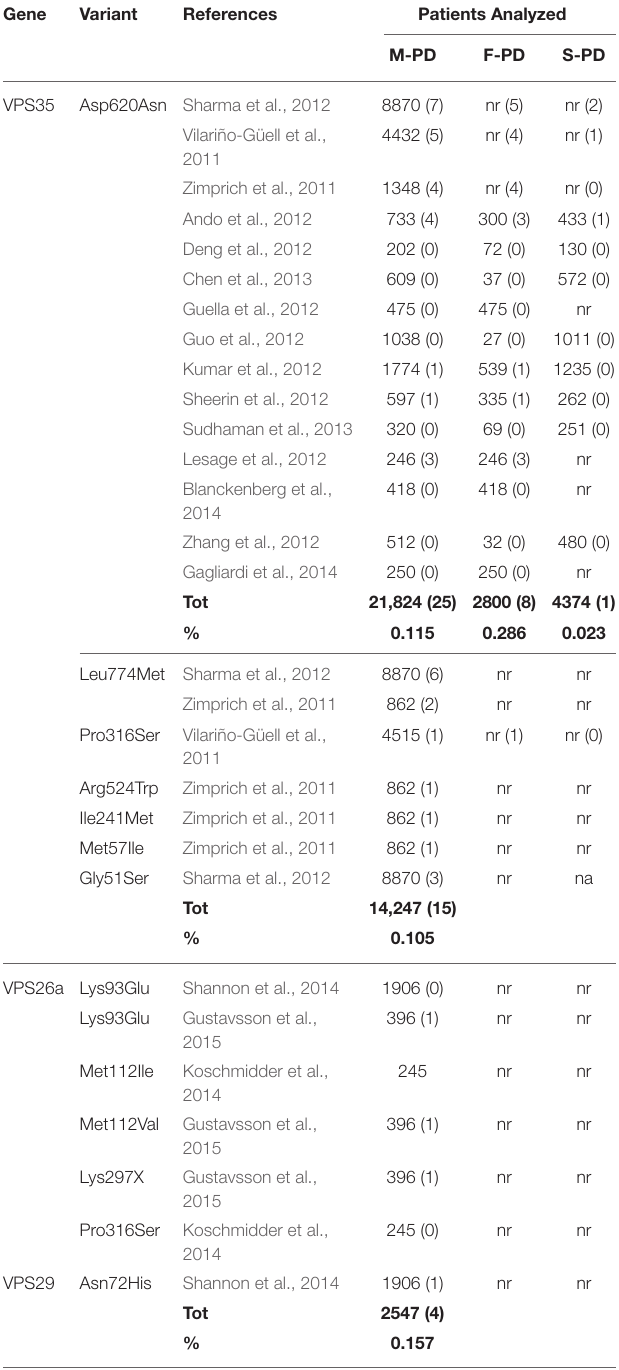
TABLE 1 | Prevalence of mutations in VPS genes.